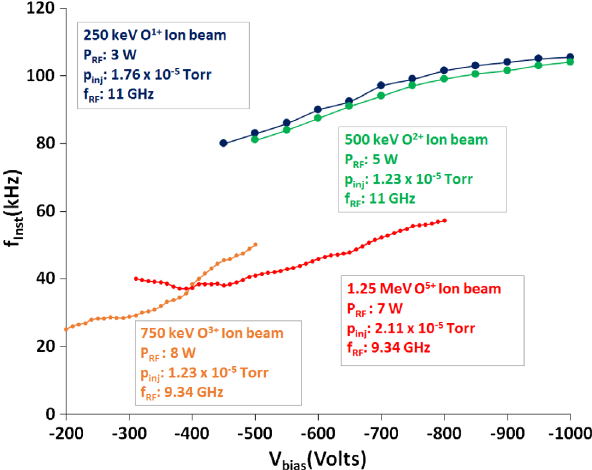
FIG. 6. Effect of bias voltage on the tunability of plasma instability frequency dominating in ECR ion source correspond- ing to Fig. 4(c) for various charge states of oxygen ion